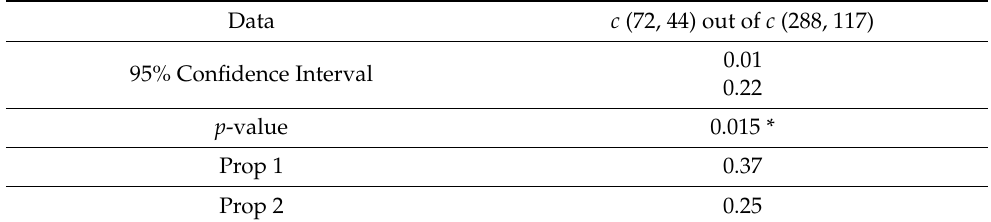
Table 8. Results of binomial test in